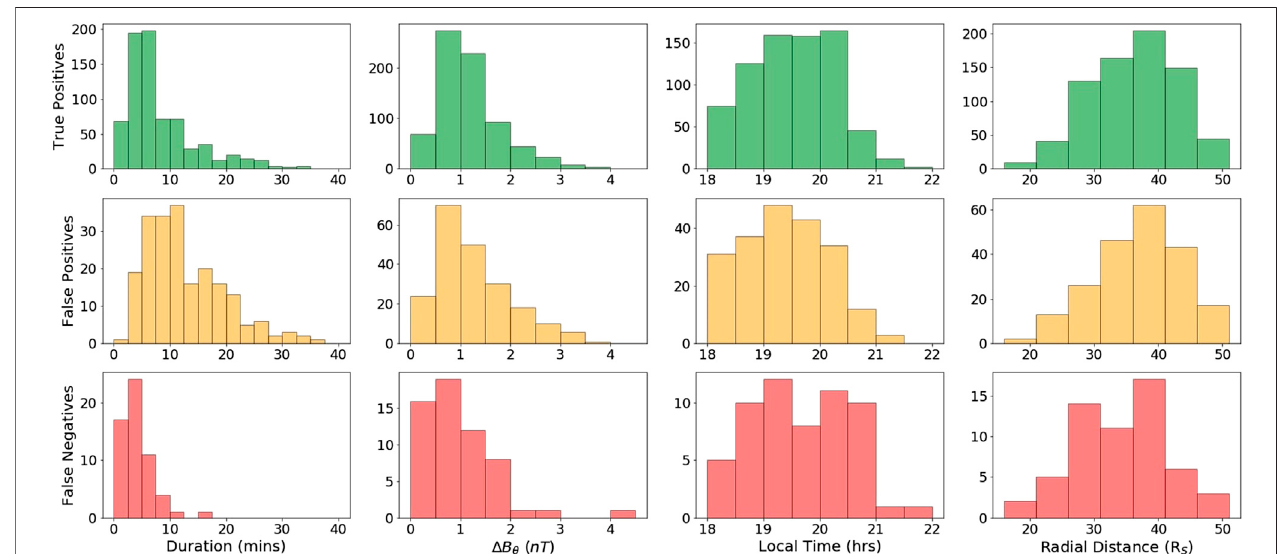
FIGURE 8 | Temporal, magnetic and spatial properties of reconnection events that are classi fi ed as true positives (green), false positives (orange), and false negatives (red) when comparing the neural network classi fi cations to those of the S16.